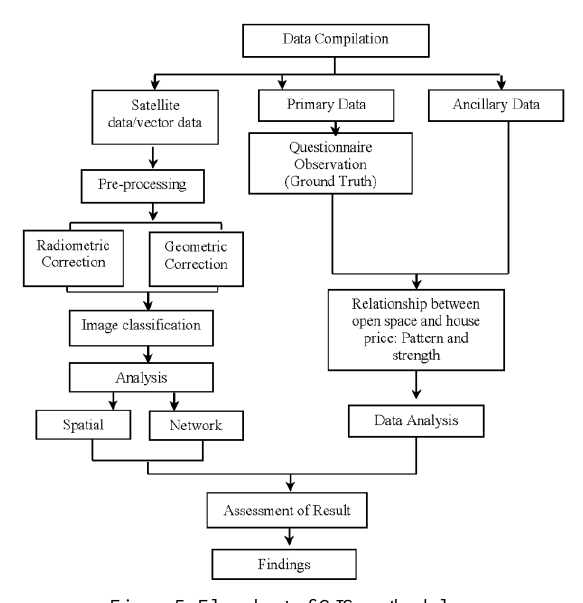
Figure 5: Flowchart of GIS